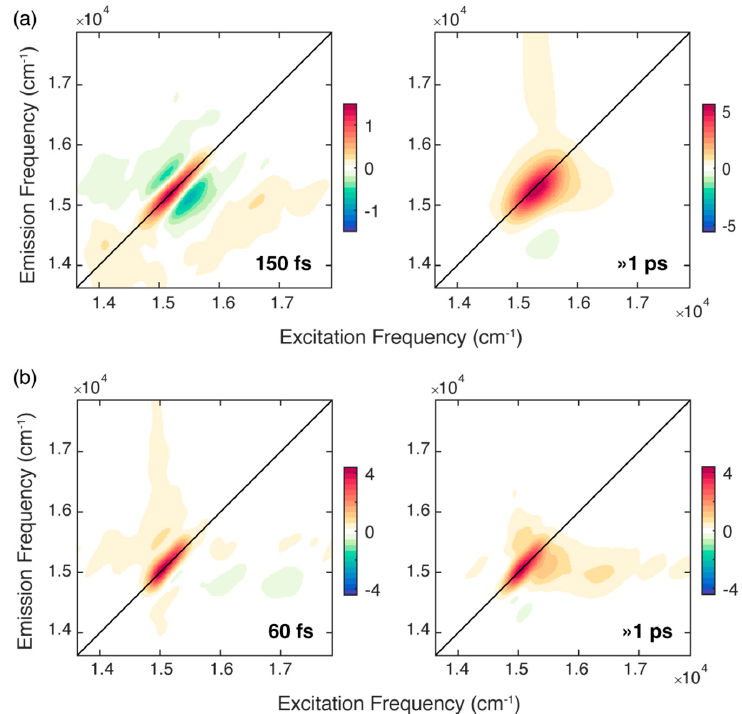
Figure 3. 2D-decay associated spectra (2D-DAS) resulting from the global fitting of the 2DES maps recorded for chl b at ( a ) RT and ( b ) 77 K. The associated time constants are reported in each panel. A positive (negative) amplitude is recorded where the signal is decaying (rising) and indicated with a red (blue) colour.